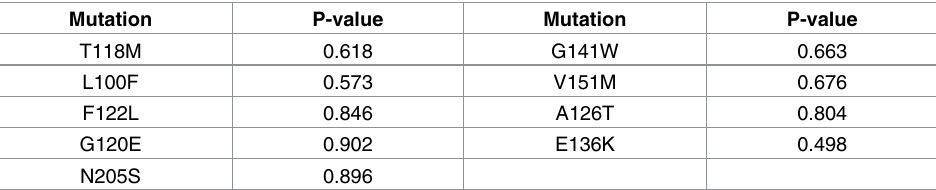
Evolutionary information is essential to detect mutations which might affect human health [52]. Using ConSurf web server, we calculated the evolutionary conservation of amino acid residues of TAGAP protein to further explore the possible effects of 9 most deleterious nsSNPs. Results were obtained in the form of structural representation of the protein (S1 Fig). ConSurf identifies structural and functional residues by combining evolutionary conservation data with solvent accessibility predictions. Highly conserved residues are predicted as either functional or structural based on their location either on protein surface or inside its core [33]. Amino acids which are involved in vital biological processes for example in interactions among differ- ent proteins, are more conserved than others. Taking this into consideration, those nsSNPs which are located at these conserved regions are considered immensely damaging to protein as compared to those at non-conserved sites [9,53]. Results obtained via ConSurf represented all residues of TAGAP showing their structural and functional conservation levels. But we focused only on those residues which matched their positions with 9 high risk nsSNPs which we have identified. The results predicted L100, T118, E136, G141, V151 and N205 as functional residues making them highly conserved and exposed. While G120, F122 and A126 are predicted as structural residues which mean that they are highly conserved and buried (Table 4). The results further confirmed these 9 high risk nsSNPs as being really deleterious to the structure and/or function of TAGAP protein. Table 2. Probability scores of deleterious